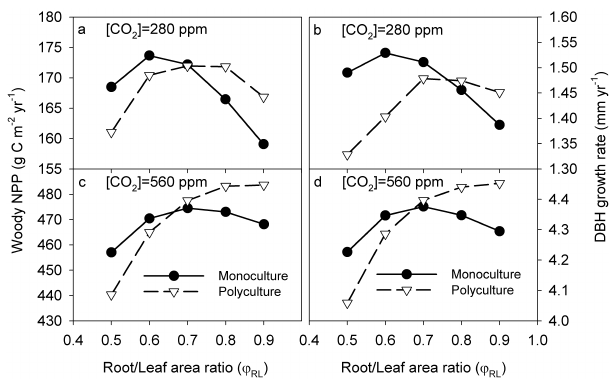
Figure 10. Woody NPP and DBH growth rates in monoculture and polyculture models runs at (a–b) [CO 2 ] = 280ppm, and (c– d) [CO 2 ] = 560ppm. PFTs differed only their allocation to fine roots ( ϕ RL ; see Fig. 8 legend for explanation). The optimal mono- culture is defined as the type with the highest woody NPP (which, given the allometries in LM3-PPA, is also the type with the high- est DBH growth rate) when grown in monoculture. In this figure, the competitive optimum is identified as the type with the high- est woody NPP (or highest DBH growth rate) in polyculture model runs. Figures 8–10 present multiple ways to identify the competitive optimum (i.e., the convergence-stable ESS), and all yield consistent results: ϕ RL = 0.7 and ϕ RL = 0.9 at 280 and 560ppm, respectively. ence between two runs of a monoculture of ϕ RL = 0.7 at